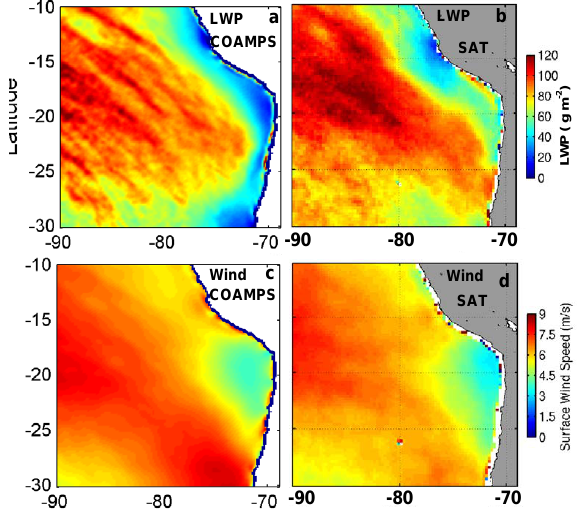
Fig. 3. Comparison of the mean LWP and surface wind speed between the COAMPS forecasts (15 km grid) and the satellite data. (a) COAMPS LWP; (b) satellite LWP; (c) COAMPS surface wind speed; and (d) satellite surface wind speed.